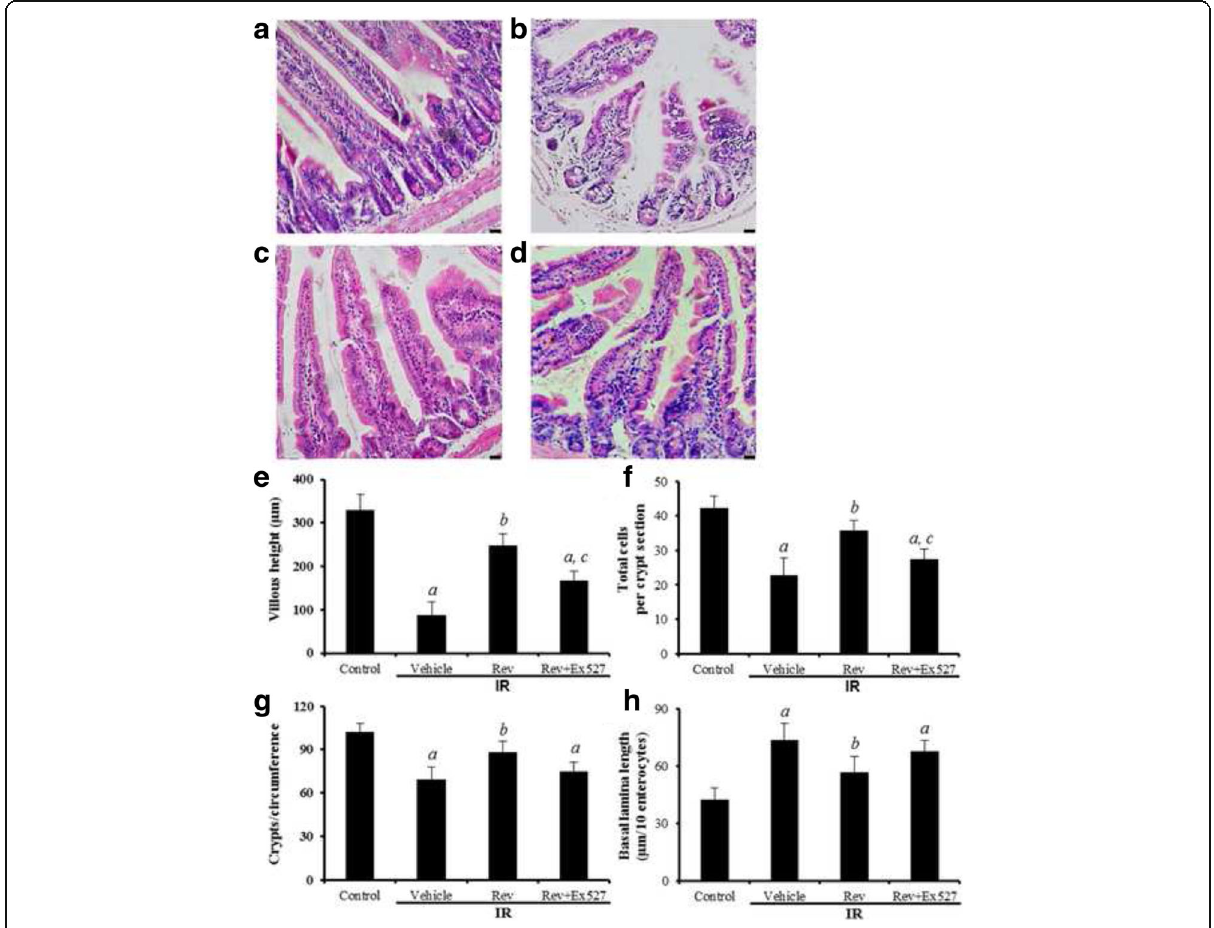
Fig. 1 Resveratrol improve intestinal cell morphology in irradiated mice. Representative images showing the villous, crypts, and the basal lamina length in cross-sections of the small intestine stained with H&E: a sham control, ( b ) vehicle-treated irradiation mice, ( c ) resveratrol treated irradiation mice, and ( d ) resveratrol plus Ex527 treated irradiation mice. Bar graphs showing Quantitative analysis of the villus height ( e ), the number of the crypt cells ( f ), the number of the crypts ( g ), and the basal lamina length ( h ). The data are presented as means ± SE. n = 6 mice per group. a p < 0.01 vs control; b p < 0.05 vs IR; c p < 0.05 vs IR + Rev. Scale bar: 20 μ